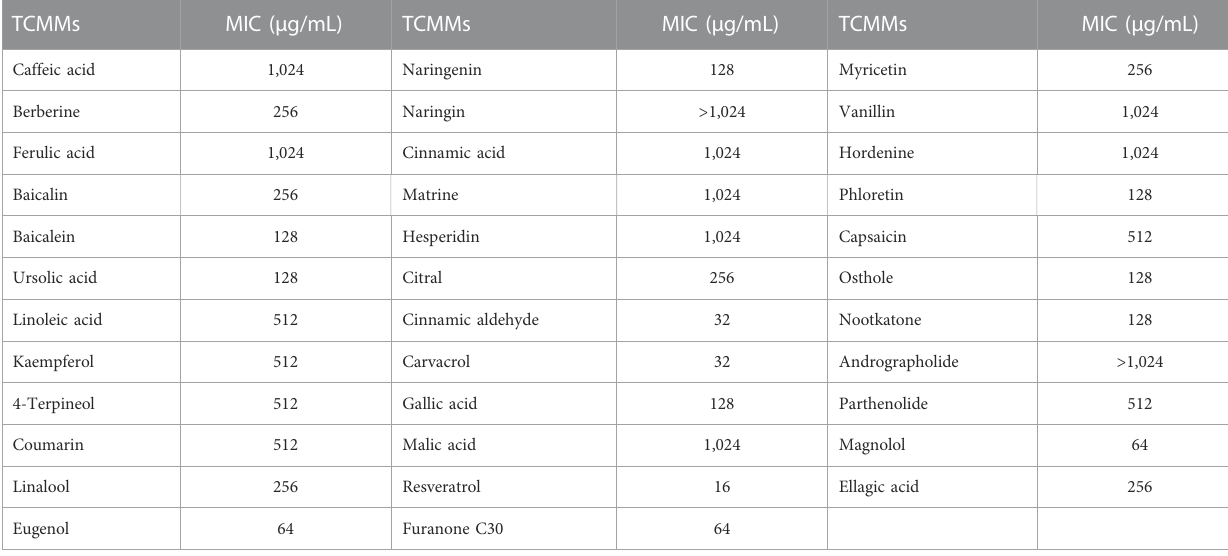
TABLE 2 MICs of 34 TCMMs against